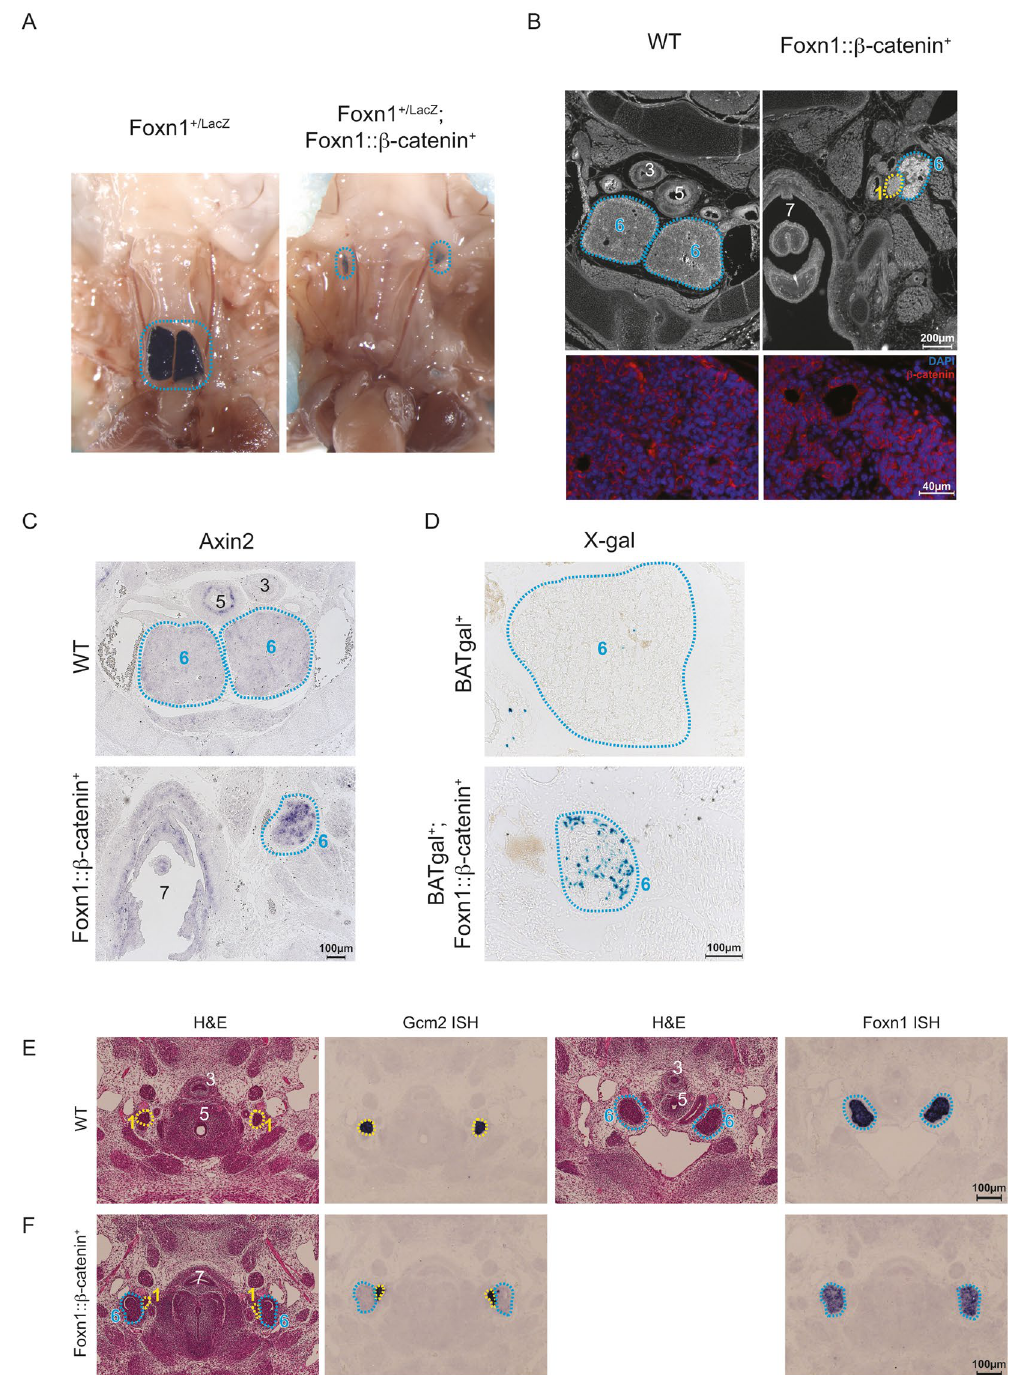
Figure 2. Defective thymus development due to TEC-intrinsic β -catenin overexpression. ( A ) Ectopic location of the thymic lobes in Foxn1:: β -catenin-transgenic mice. Foxn1-expressing thymic lobes are labelled blue by wholemount X-Gal staining. ( B ) Ectopic location of thymic lobes and parathyroid in E15.5 β -catenin-transgenic embryos, visualised by staining for β -catenin (upper panels 20x panoramic view, lower panels thymus tissue at 40x magnification with DAPI counterstain). ( C ) RNA in situ hybridization for Axin2 on thymus sections of E15.5 embryos. ( D ) Activity of the BATgal reporter allele in the thymus of E15.5 embryos. ( E ) Development of the parathyroid and thymus of wild-type mice at E12.5 examined by H&E staining and RNA in situ hybridization with the indicated gene-specific probes. ( F ) Development of the parathyroid and thymus of mutant mice at E12.5 examined as in ( E ). A numerical key for the histological labels can be found in Fig.